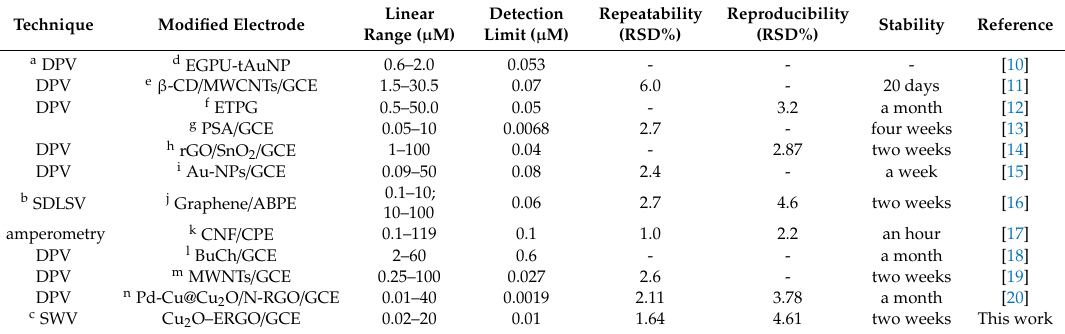
Table 1. Comparison of results of Trp sensing between this study and previous reports. Linear Technique Modified Electrode Range ( µ